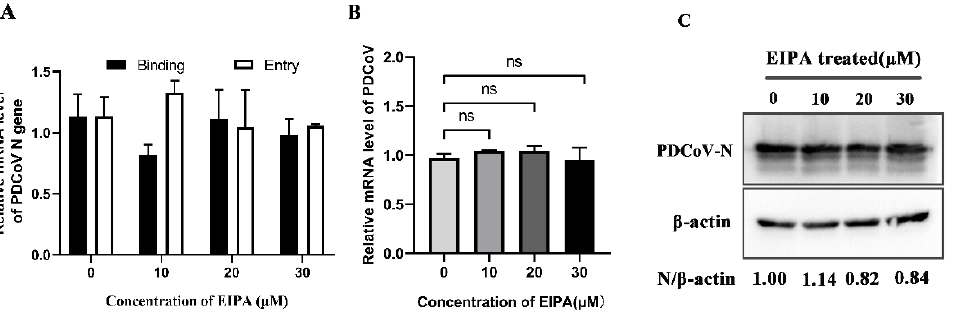
Figure 5. PDCoV entry does not depend on macropinocytosis. ( A ) PK-15 cells were pretreated with 5-(N-ethyl-N-isopropyl) amiloride (EIPA) at 37 °C for 1 h and infected with PDCoV (MOI of 5) at 4 °C for 1 h (binding step), and then shifted to 37 °C for 1 h (entry step). Cells were lysed to determine viral mRNA level by RT-qPCR. Cells were mock-treated or treated with EIPA for 1 h followed by infection with PDCoV (MOI = 0.1). At 24 hpi, mRNA expression levels of total PDCoV were detected by real-time quantitative PCR ( B ) and protein expression levels of intracellular PDCoV were detected by Western blotting ( C ). ns: no significant difference.